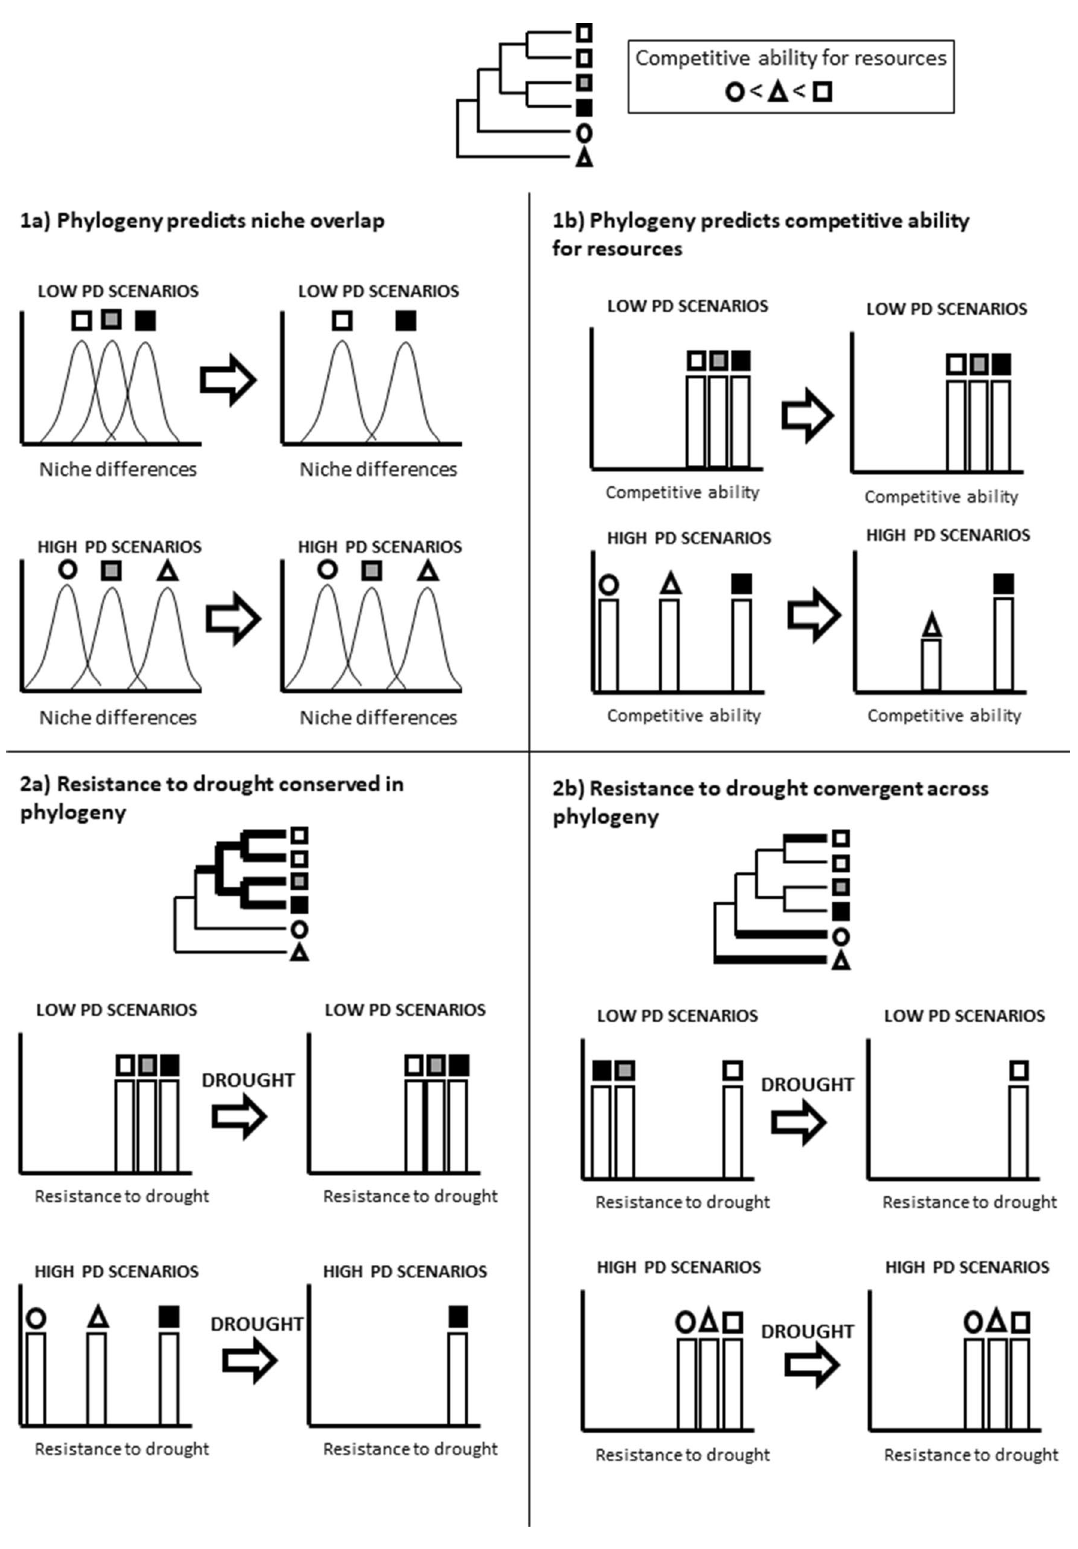
Figure 1. Conceptual model illustrating the hypotheses on the mechanisms involved in the assembly of the annual plant community related to phylogenetic diversity. (1) If phylogenetic relatedness predicts the intensity of niche overlap-differentiation among species, then plants will coexist more readily in high phylogenetic diversity scenarios due to functional/niche complementarity. Conversely, if phylogenetic relatedness predicts the competitive ability of species, then coexistence will be more likely to occur in low phylogenetic diversity scenarios (i.e., competition symmetry will enhance the coexistence among similar competitors). (2) If functional traits related to water economy are phylogenetically conserved, the response of plants to drought would be more heterogeneous in high diversity assemblages, resulting in a faster decline of species richness. In contrast, if water economy traits in the species pool are convergent among distantly related taxa, phylogenetically diverse assemblages will be more resistant to drought than those formed by close